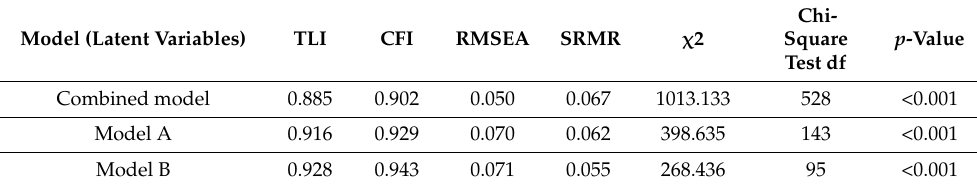
Table 2. Fit statistics for full measurement model. Table 3. Fit statistics for structural equation